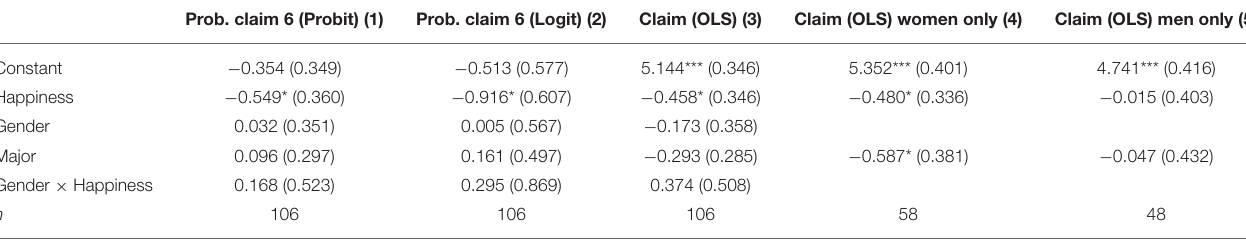
TABLE 2 | Determinants of claiming a six and of overall roll claimed. Prob. claim 6 (Probit)